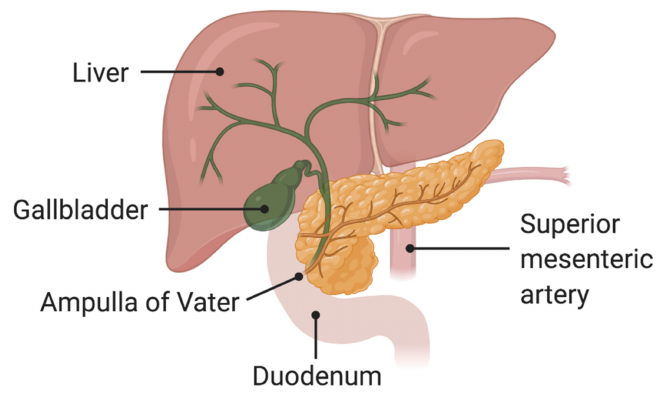
Figure 1. Schematic representation of the ampulla of